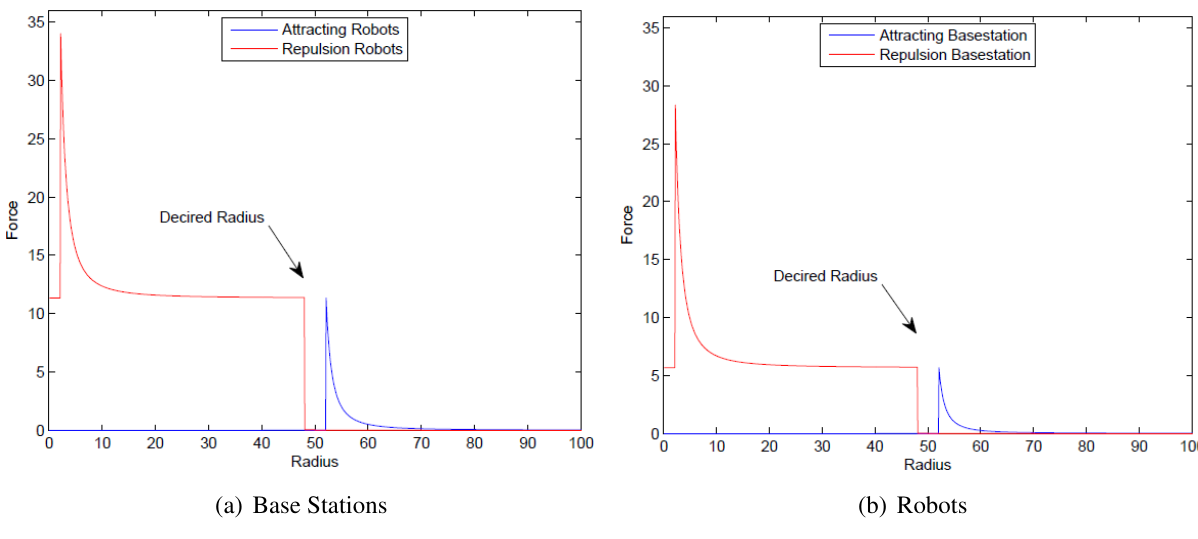
Figure 6. The Artificial Physics-based potential